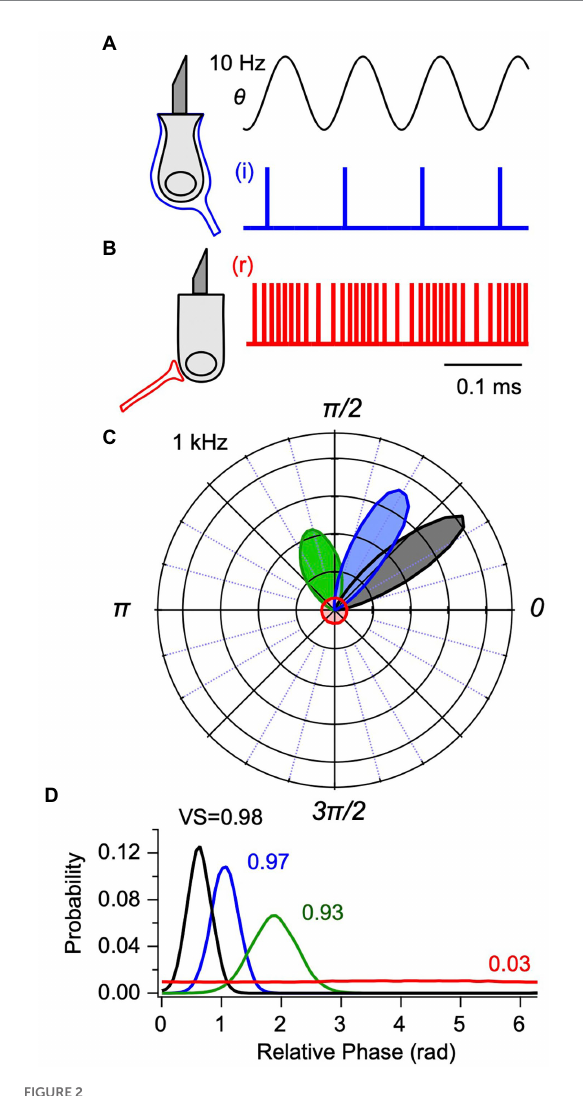
FIGURE 2 Integrate-and-fire (IAF) model for utricular afferent action potential generation. Simulated spike times are shown for: (A) a phase-locking afferent contacting type I hair cells with calyx [ (C) blue, i-irregular] synaptic terminals and (B) a non-phase-locking afferent contacting type II hair cells with bouton [ (B) red, r-regular] synaptic terminals (from Eq. 9). (A,B) Responses are shown for 10 Hz sinusoidal shear ( ) sin 0 t θ θ ω= generated by BCV. Phase-locking afferents fire action potentials at a precise phase relative to the sinusoidal stimulus, illustrated for one example neuron in response to 1,000 Hz BCV in (C,D) as polar and cartesian probability density functions, or phase histograms (Eq. 11). For the IAF model, the vector strength (VS) increases and the mean latency decreases as the stimulus strength increases (black: VS = 0.98, blue: 0.97, green: 0.93). For comparison, the phase histogram of regularly discharging unit that does not phase-lock to the 1,000 Hz stimulus is also shown (red).